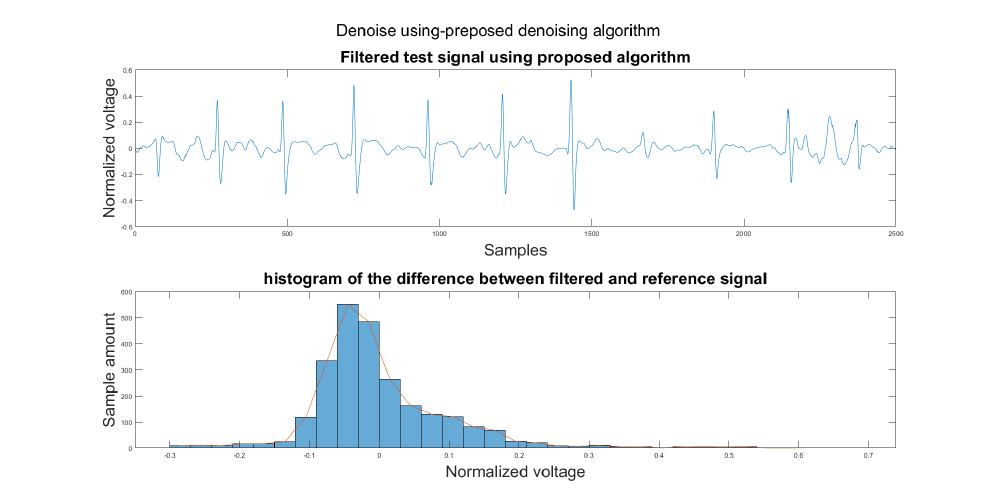
Figure A29. (1) Test signal, (2) histogram of the